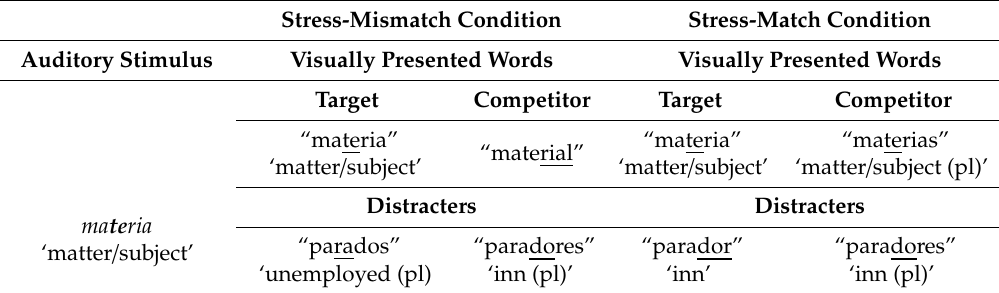
Table 3. Example stimuli in the cognate